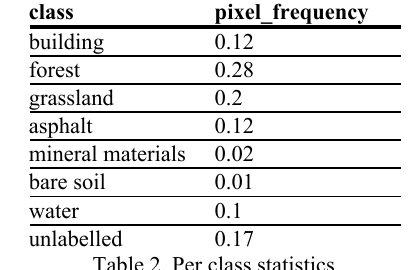
Table 2. Per class statistics